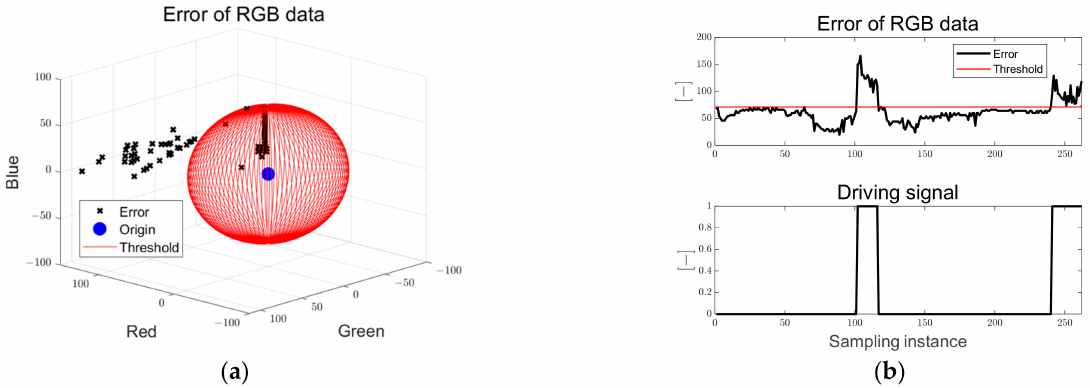
Figure 24. Lane-change path tracking scenario results; ( a ) error of RGB data; ( b ) driving flag signal.